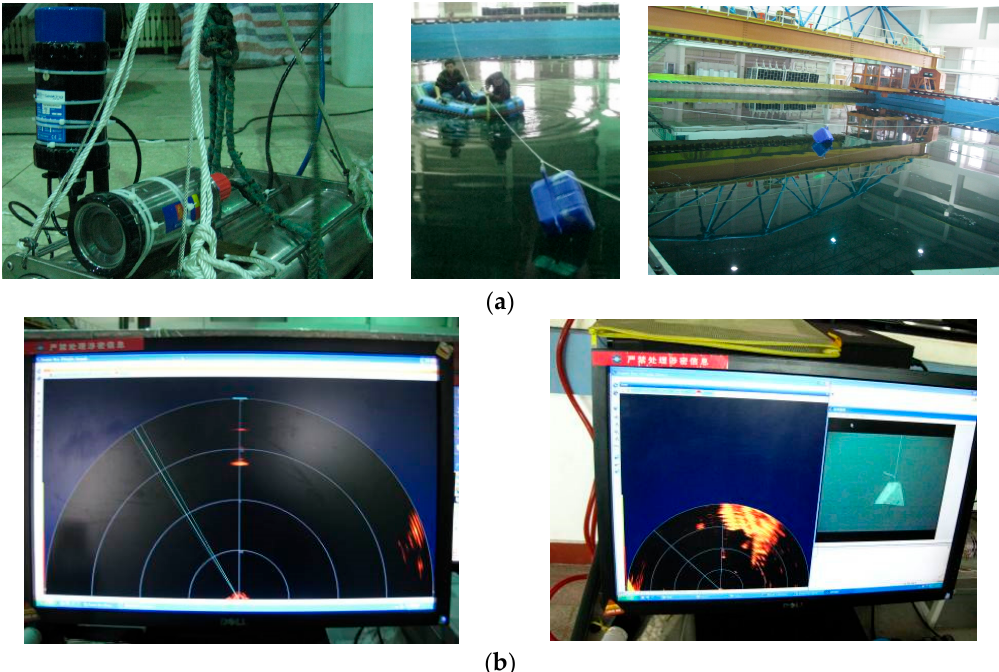
Figure 4. Experiment scene: ( a ) sonar and target launch and ( b ) collected data.